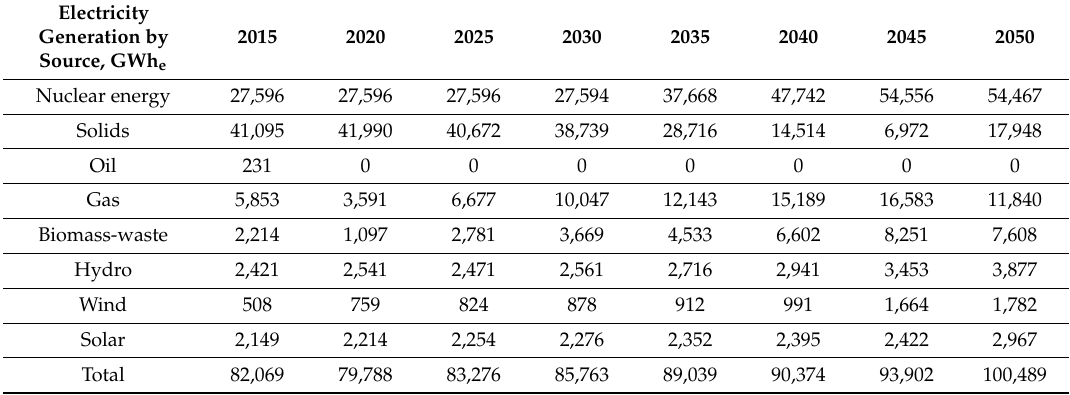
Table 2. Outlook of electricity generation in the Czech Republic